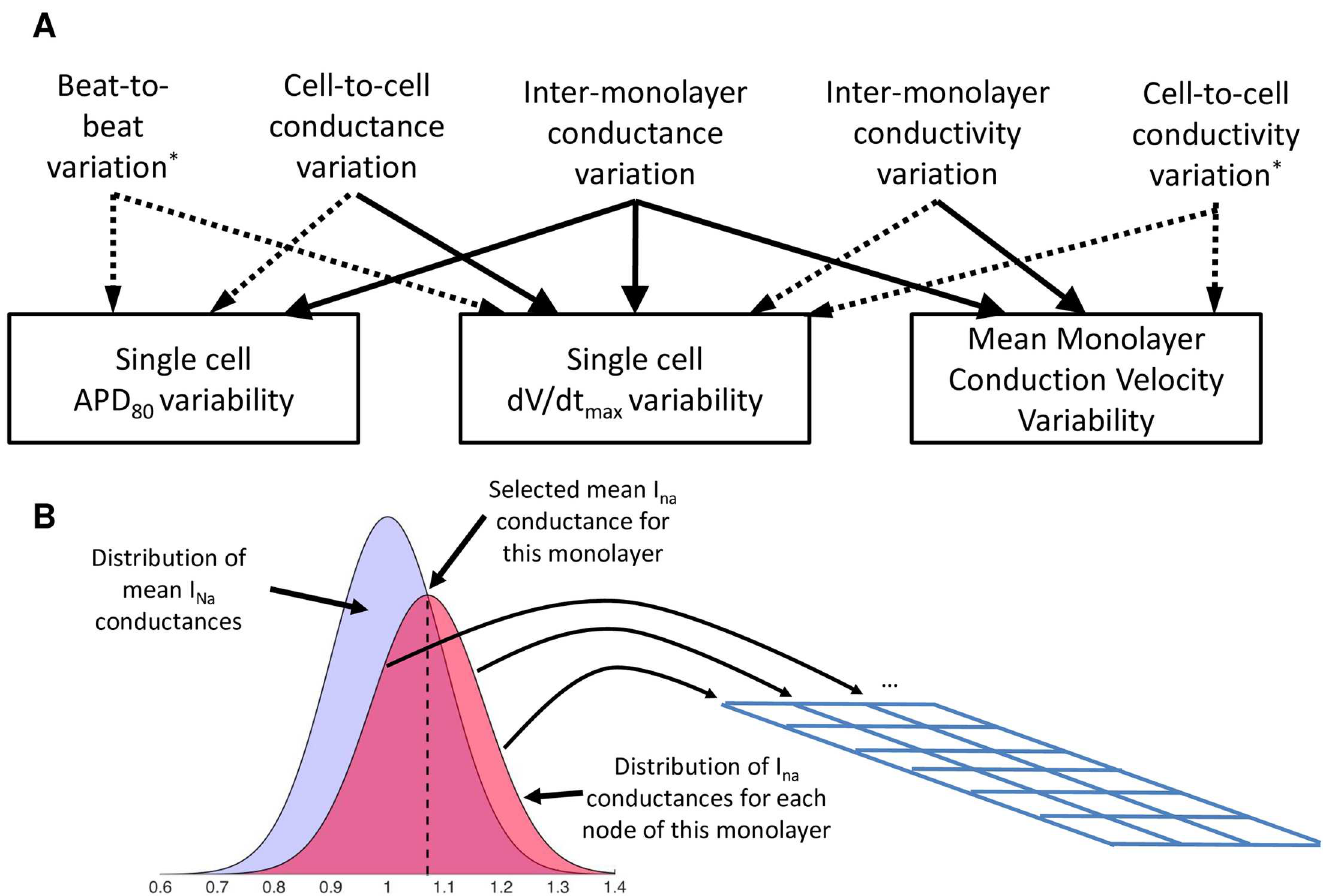
Fig 4. Modeling variability. (A) Types of variation and their relative impacts on measuredproperties.Significantlinkagesare shown with solid lines while weak effects are shownwith dashedlines. Types of variation marked with an asterisk are not describedin depth but are includedfor completeness (B) In order to model both cell-to-celland inter-monolayerconductance variability, a mean monolayerconductance(black dashed line) is selectedfrom a random normaldistribution(blue distribution).The conductanceof each node within the monolayeris then selectedfrom a random normal distribution aroundthe mean monolayerconductance(red distribution)